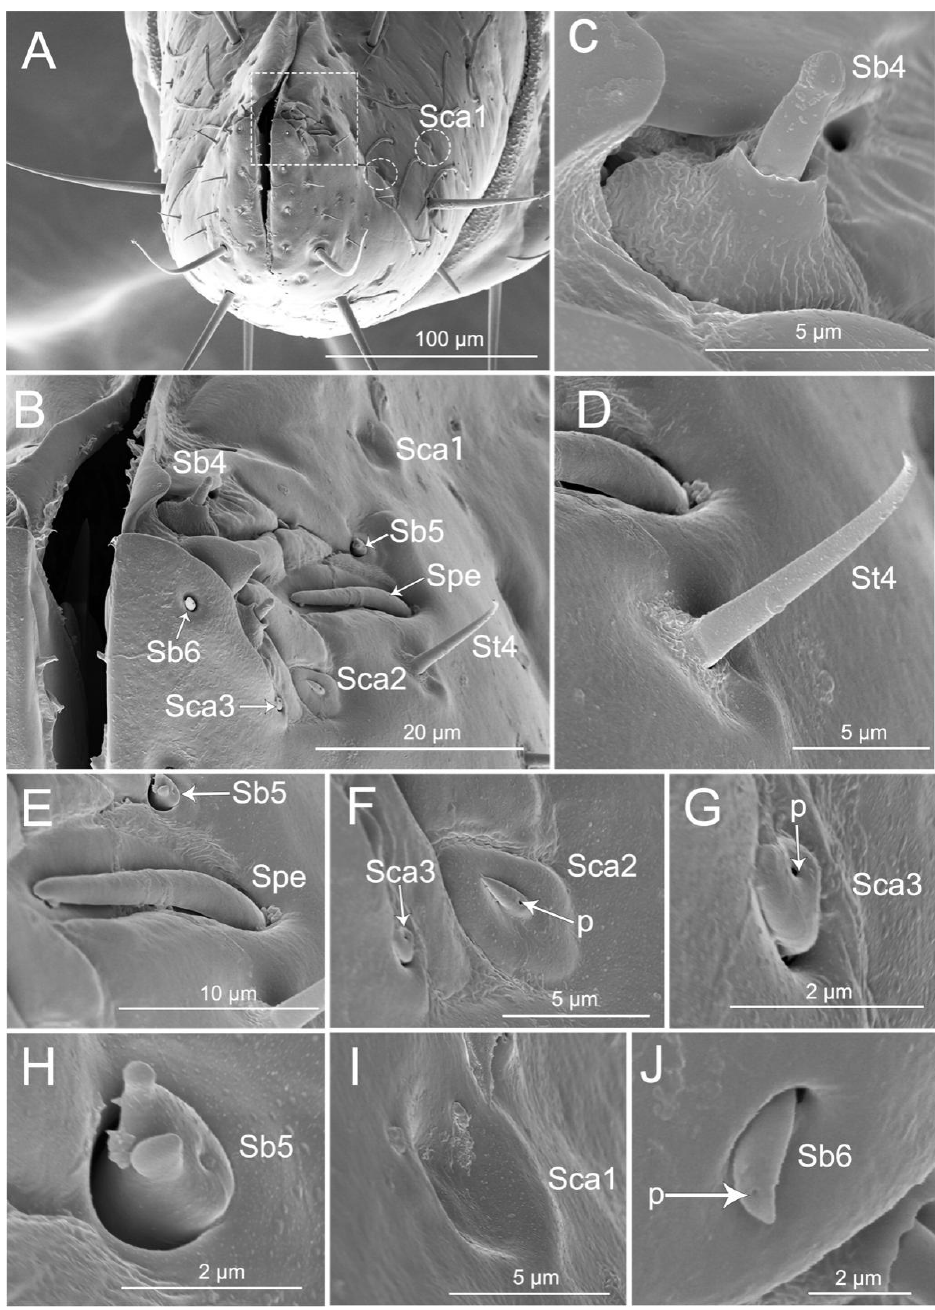
Figure 6. SEM of tip of labium of Haematoloecha nigrorufa . A. Vertical view; B. Enlarged view of box in (A), showing sensilla trichodea (St4), sensilla placodeum elongated (Spe), three type of sensilla campaniform (Sca1, Sca2, Sca3), and three type of sensilla basiconica (Sb4, Sb5, Sb6); C. Sensilla basiconica (Sb4); D. Sensilla trichodea (St4); E. Placoid elongated sensilla (Spe) and sensilla basiconica (Sb5); F. Sensilla campaniformia (Sca2) and sensilla campaniformia (Sca3); G. Sensilla campaniformia (Sca3); H. Sensilla basiconica (Sb5); I. Sensilla campaniformia (Sca1); J. Sensilla basiconica (Sb6); p , pore.